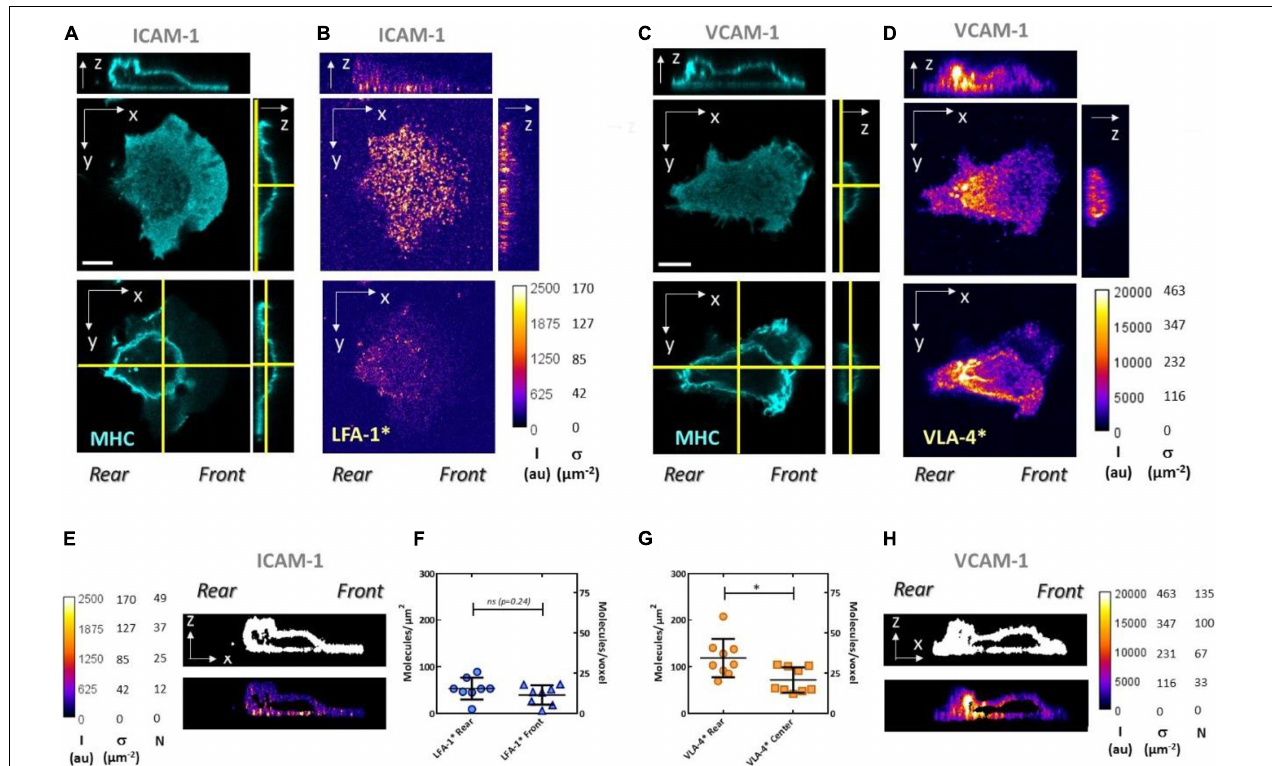
FIGURE 8 | Quantitative confocal microscopy reveals high-affinity integrin distribution and density at the surface of crawling lymphocytes. Confocal imaging of cells crawling either on ICAM-1 (A,B,E,F) or VCAM-1 (C,D,G,H) . Immunostaining is used to reveal MHC proteins with Ab W6/32 (A,C) , integrins LFA-1 in high affinity with Ab M24 (B) , and β 1 integrins (including VLA-4) in high affinity with Ab HUTS4 (D) . Top x–y images correspond to the basal plane, while bottom ones correspond to a mid-section of the cells. The heights where x–y images were taken are indicated by the yellow vertical lines in the corresponding y–z cross sections next to them. Section positions of the x–z and y–z images are indicated by yellow horizontal and vertical lines, respectively, in the bottom x–y images. Color scale bars are graduated for raw intensity, I (au), and surface density of high affinity integrins, σ ( µ m − 2 ). White scale bar is 5 µ m. Mask created from the x–z cross section of MHC (top) and immunofluorescence intensity within the mask (bottom) for high-affinity integrins LFA-1 (E) and VLA-4 (H) . Color scale bars are graduated for raw intensity, I(au), surface density of high-affinity integrins, s ( µ m − 2 ), and number of molecules per voxel, N. Average density of high-affinity integrins measured at the basal plane, on cell front and rear for LFA-1 (F) , and on cell rear and center for VLA-4 (G) . Values are calculated based on the raw intensity on the basal plane minus the average background on the substrate. Ncells > 15. * P < 0.05 (two-tailed Student’s